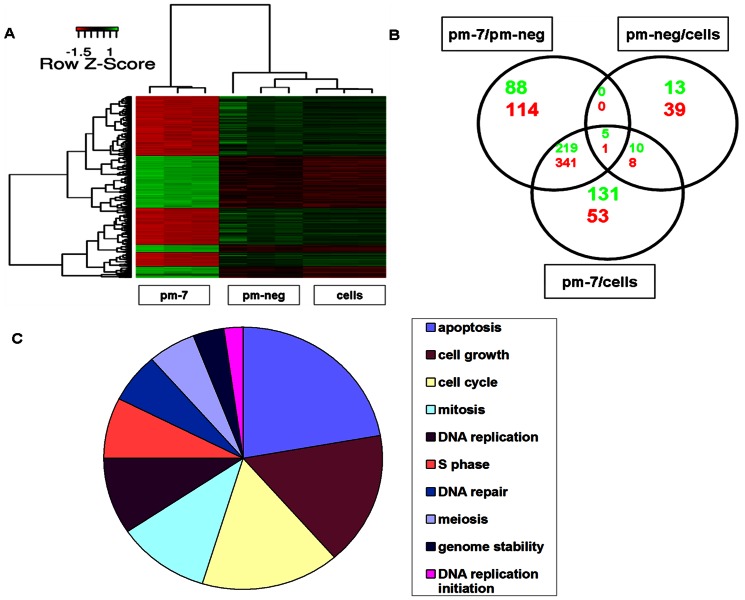
Transcriptomic analysis of miR-7 transfected cells.Following pm-7 or pm-neg transfection, gene expression profiling was performed on biological triplicates using oligonucleotide arrays. Genes were considered to be differentially expressed and statistically significant if a 1.2 fold change in either direction was observed along with a Bonferroni adjusted p-value<0.05. Using the LIMMA method and Bonferroni algorithm, gene expression between the three groups was evaluated and compared (A). Unique and commonly differentially expressed probesets across the three comparisons were identified (B). Red: Down-regulated; Blue: Up-regulated. The biological processes most significantly represented by these DE genes were identified in silico using PANTHER and Pathway Studio (C).